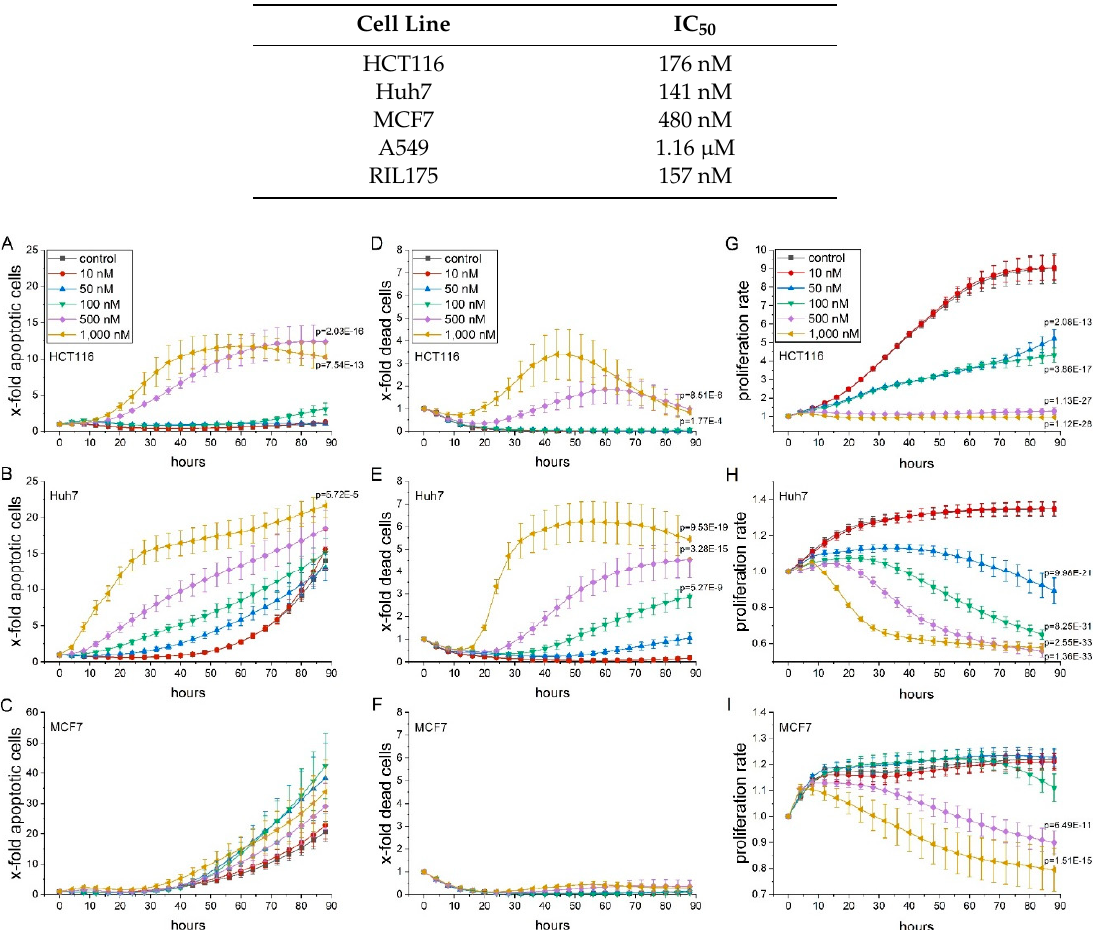
Table 2. IC 50 values (nM) ± SEM of thioA against HCT116, Huh7, and MCF7 tumor cell lines based on Table 1. IC 50 values of thioholgamide A (thioA) against a panel of tumor cell lines measured in the caspase 3/7 activity, membrane permeability, and cell confluency measured by automated metabolic viability MTT assay after 48 h treatment. microscopy; calculated for 48 h treatment.